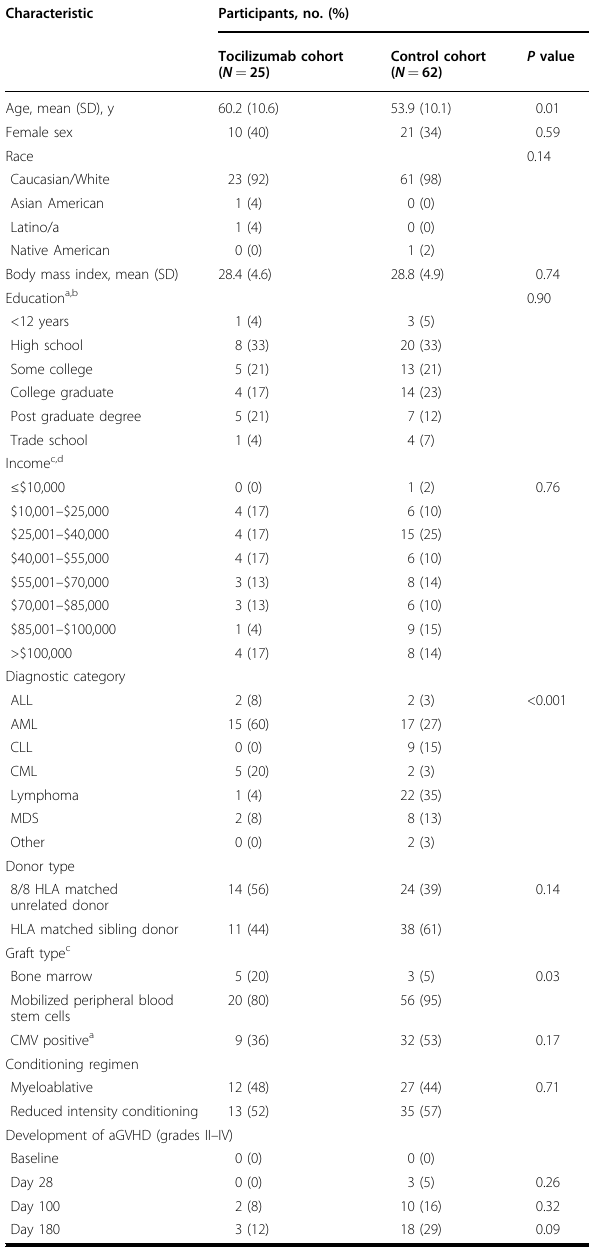
Table 1 Demographic and clinical characteristics.